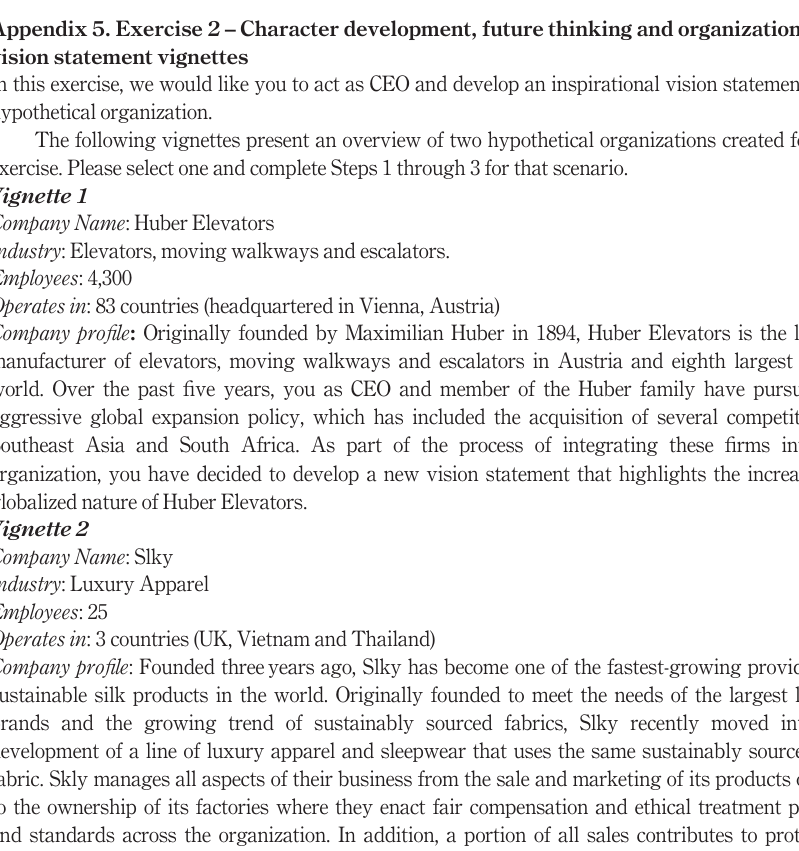
Table A4. Summary table of the judges scores